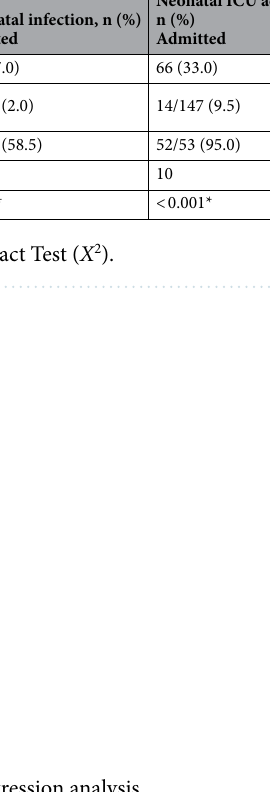
Table 3. Predictive factors of neonatal outcomes based on of logistic regression analysis.